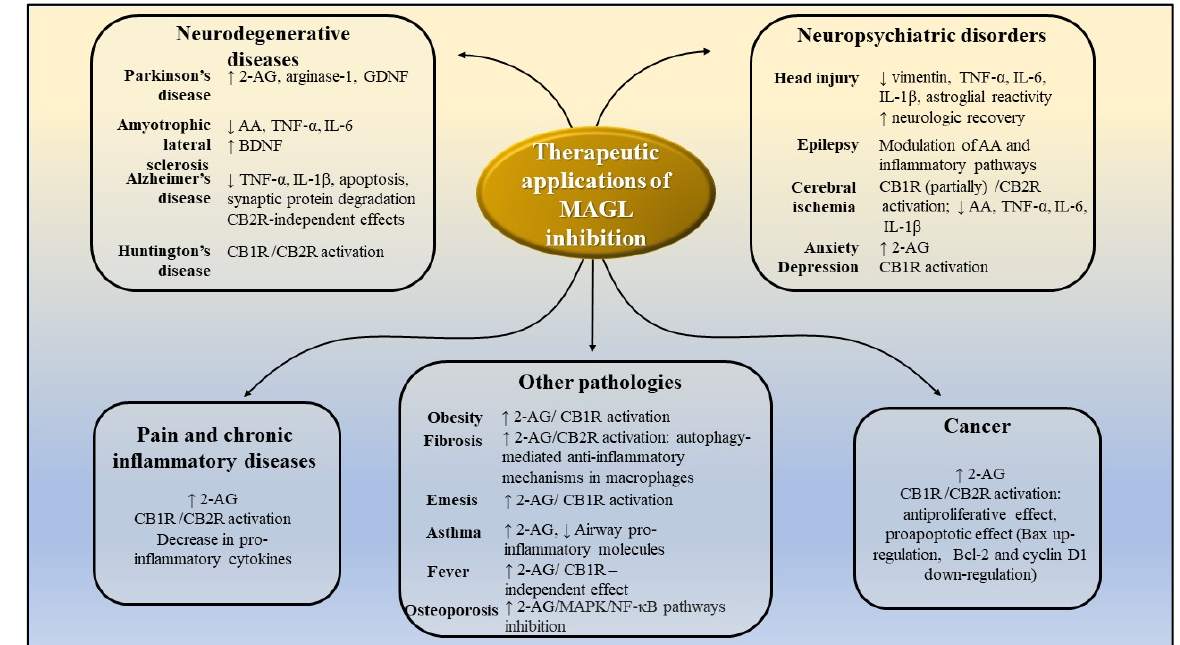
Figure 13. Potential therapeutic application of MAGL inhibitors, as demonstrated by preclinical studies. AA-arachidonic acid; 2-AG-2-arachidonoylglycerol; CB1R—cannabinoid receptors 1; CB2R—cannabinoid receptors 2; IL-1 β -interleukin-1 β ; IL-6—interleukin 6; TNF- α -tumor necrosis factor α ; MAPK- mitogen-activated protein kinase; NF-kB—nuclear factor kappa-light-chain-enhancer of activated B cells; GDNF—glial cell line-derived neurotrophic factor; BDNF—brain-derived neurotrophic factor.